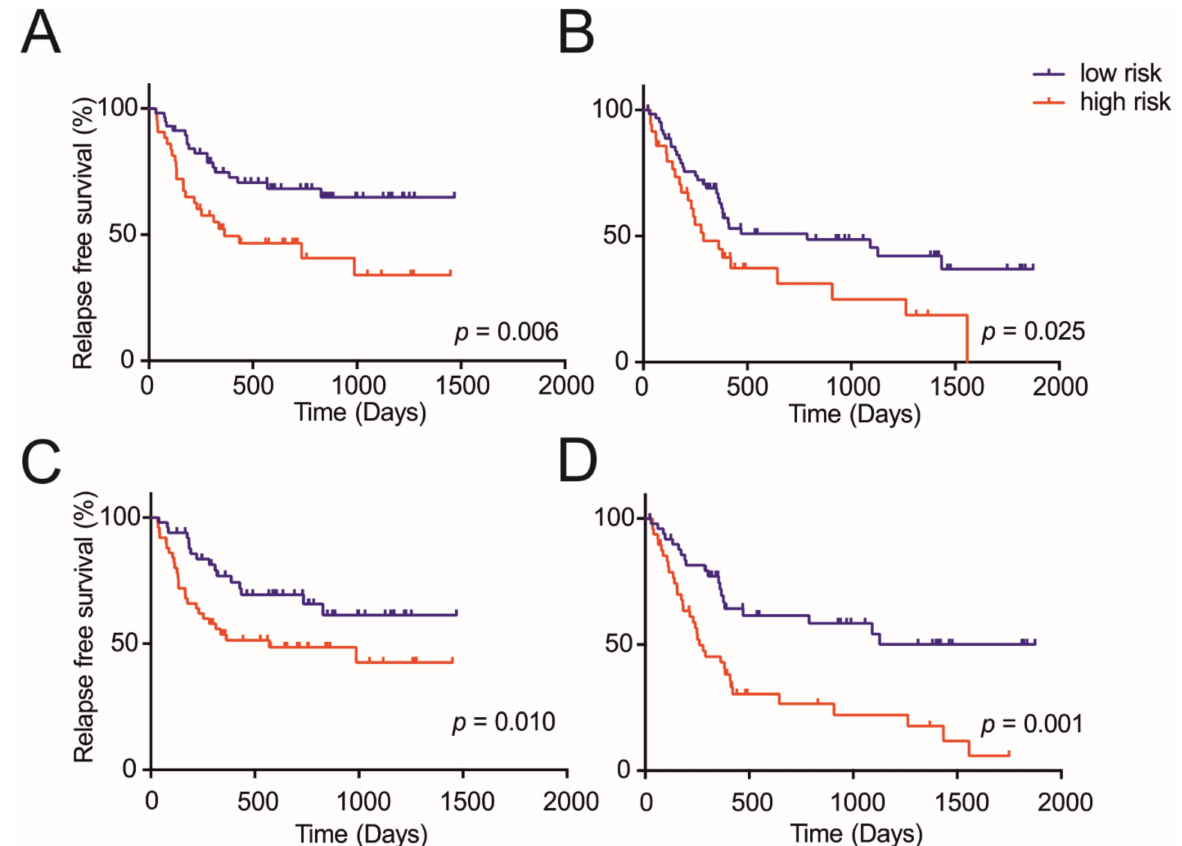
Figure 5. Recurrence-free survival (RFS) according to risk groups defined by the clinicopathological and metaboclinico- pathological model. Clinicopathological model ( A ) derivation group and ( B ) validation group. Metaboclinicopathological model ( C ) derivation group and ( D ) validation